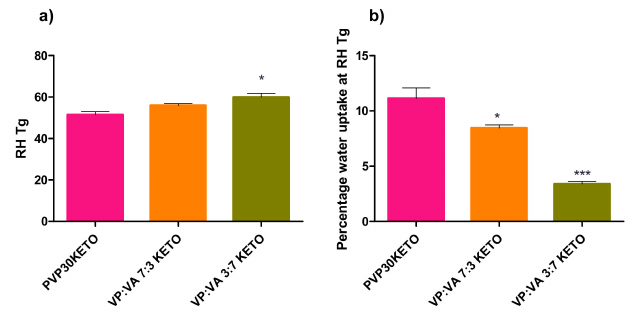
Figure 9. ( a ) The relative humidity at which a glass transition was induced for polymer–ketoprofen systems of di ff ering VP:VA substitution ratios. ( b ) The mass percentage of water uptake for polymer–ketoprofen systems at the relative humidity induced glass transition for di ff ering VP:VA substitution ratios. Statistically significant di ff erence ( p < 0.05) from PVP30KETO system denoted by *. Highly statistically significant di ff erence ( p < 0.001) from PVP30KETO system denoted by